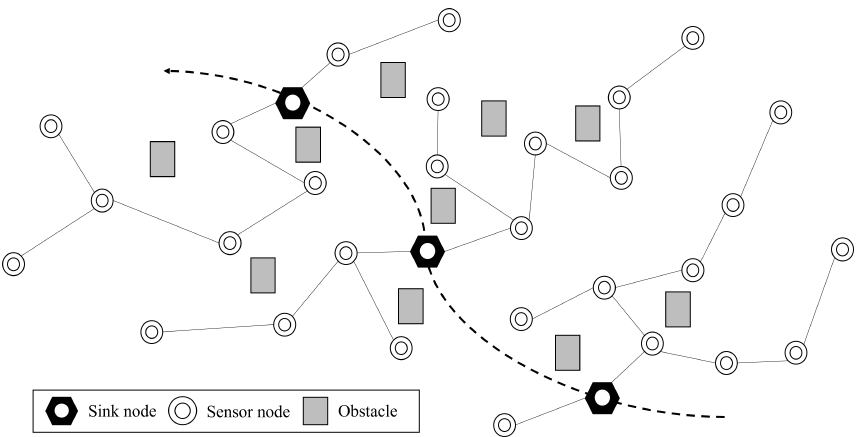
Figure 1. An example: deployment of sink nodes and sensor